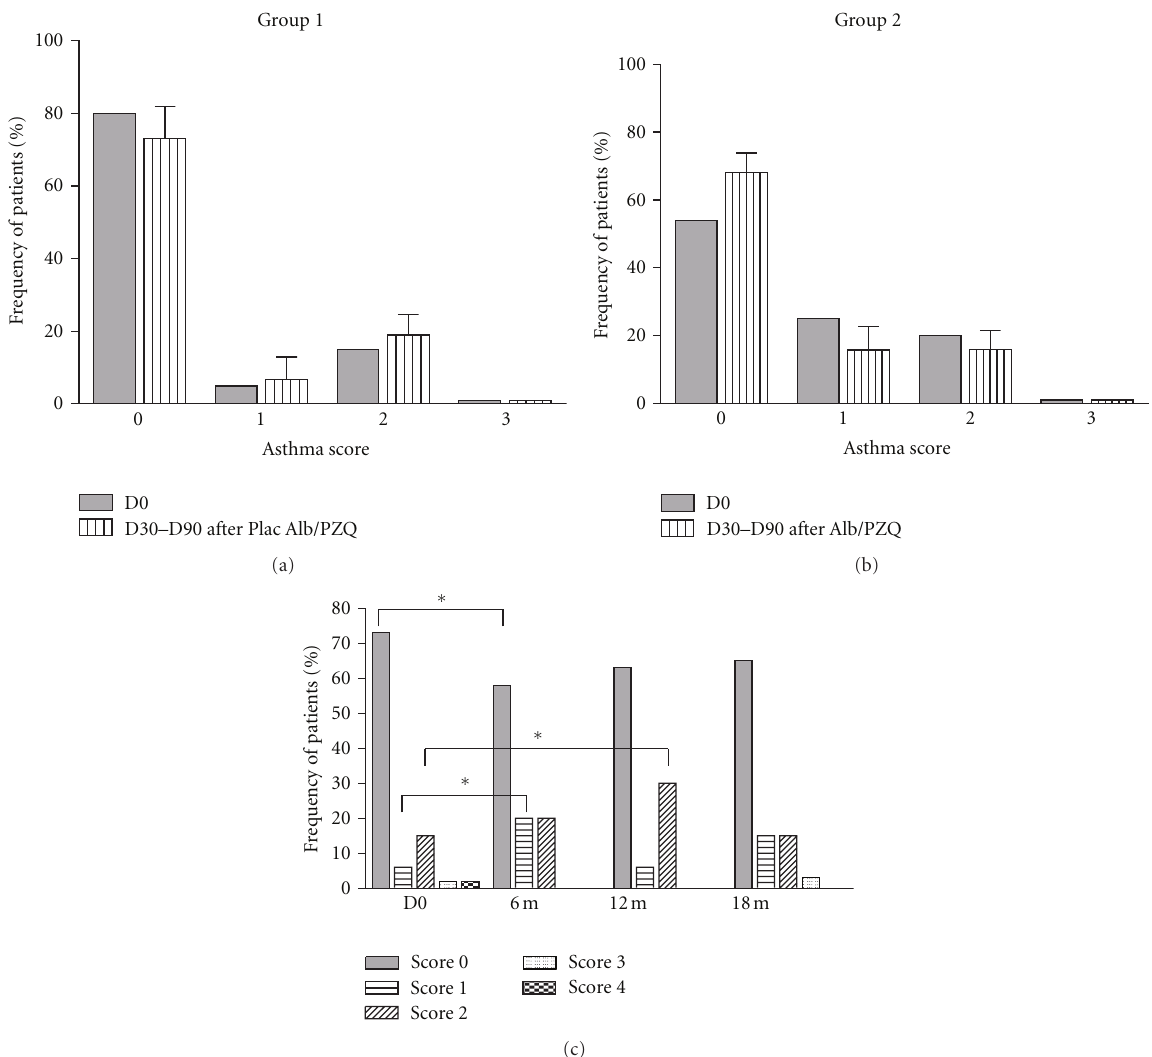
Figure 3: Frequency of clinical scores of asthma at day zero (D0) and day 30 to day 90 (D30–D90) after treatment with placebo (Plac) of Albendazole (Alb) and placebo of Praziquantel (PZQ) (Group 1; (a)); and frequency of clinical scores of asthma at day zero (D0) and day 30 to 90 (D30–D90) after treatment with Albendazole and Praziquantel (Group 2; (b)). Data were represented as mean ± SD. (c) shows the frequency of clinical scores of asthma (0, 1, 2, 3, 4) at day zero (D0) and at 6 months, 12 months and 18 months after treatment with Praziquantel (Figure 3(c)). Patients were evaluated monthly from day 30 to day 90 (D30–D90). After 90 days of enrollment, both placebo and treatment groups were treated with Albendazole and Praziquantel. From there clinical scores of asthma were assessed each 6 months for a total period of 18 months. ∗ D0 versus 6m or D0 versus 12m, P < 0 . 05; Fisher’s exact